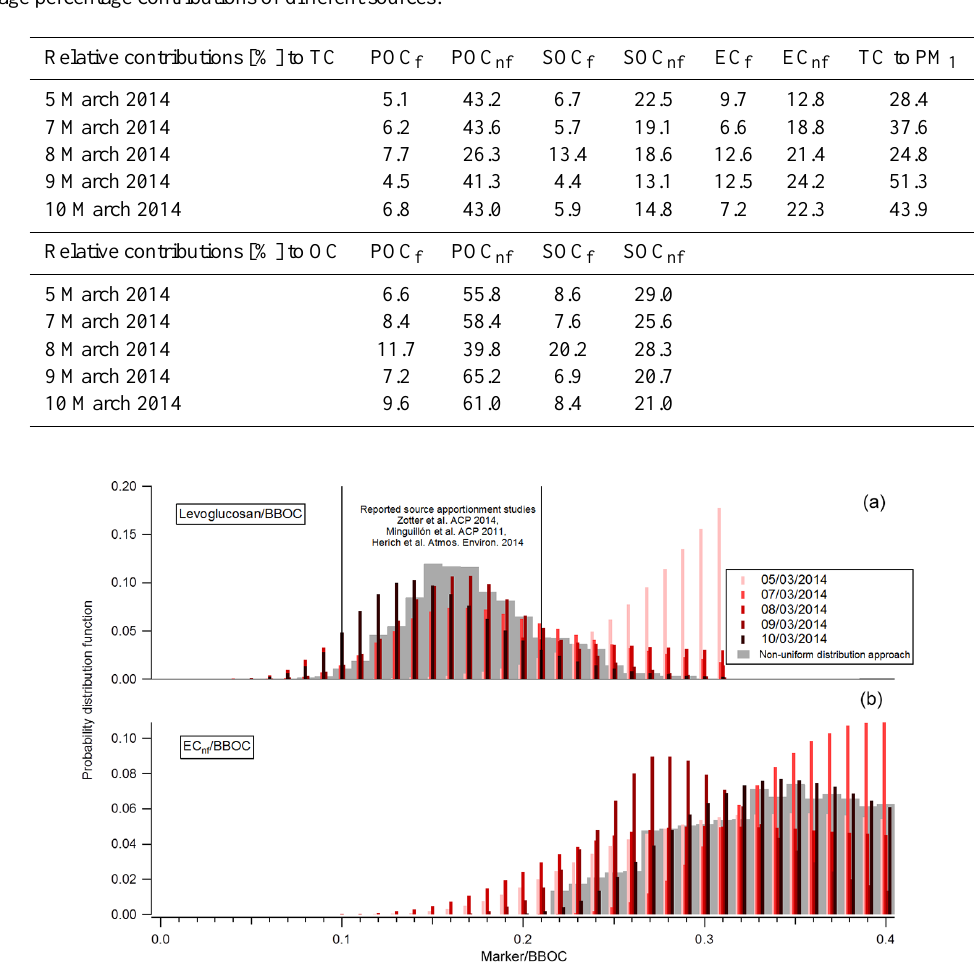
Figure 8. Please correct caption to: Probability distribution functions of Levoglucosan = BBOC (a) (Zotter et al., 2014; Minguillón et al., 2011; Herich et al., 2014) and EC nf = BBOC (b)